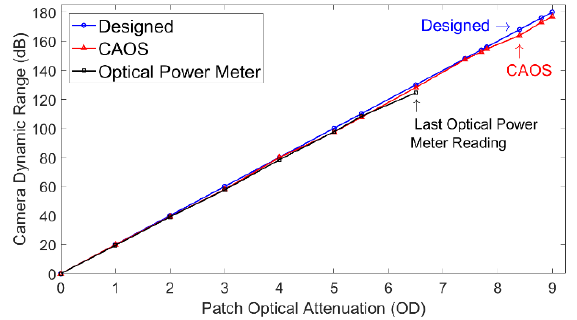
Fig. 1. Linear 177 dB XDR response using Table 5 Data